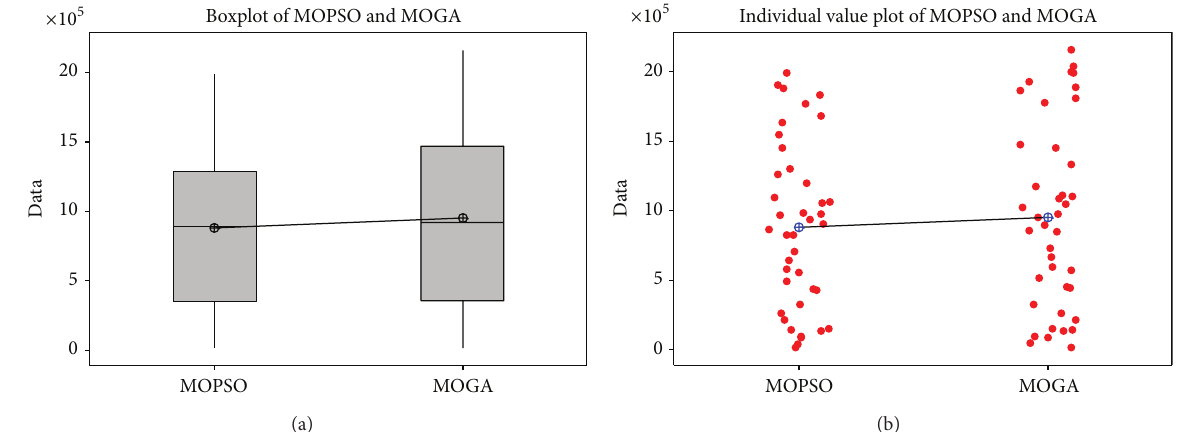
Figure 7: The boxplot and the individual value plot of the performances of the algorithms.